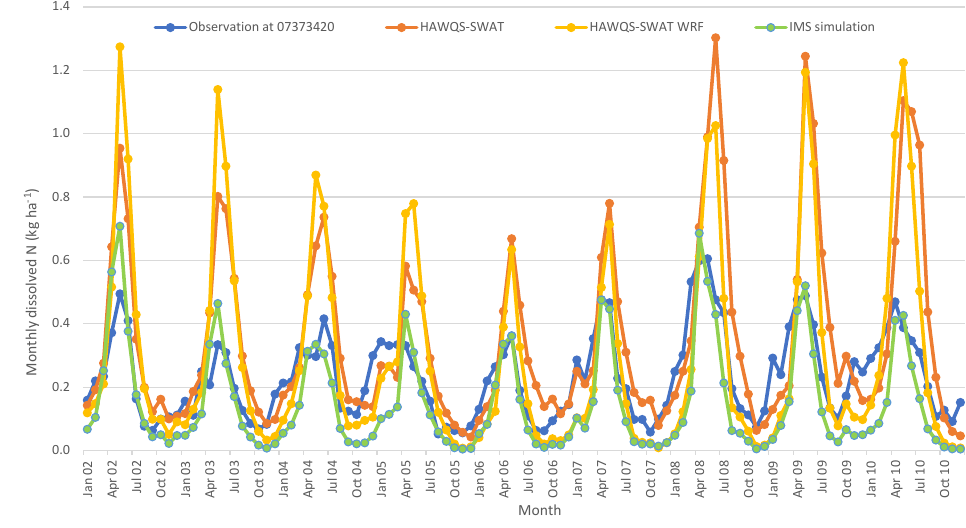
Figure 7. Monthly dissolved N evaluation at the total outlet of the MRB (USGS 07373420).